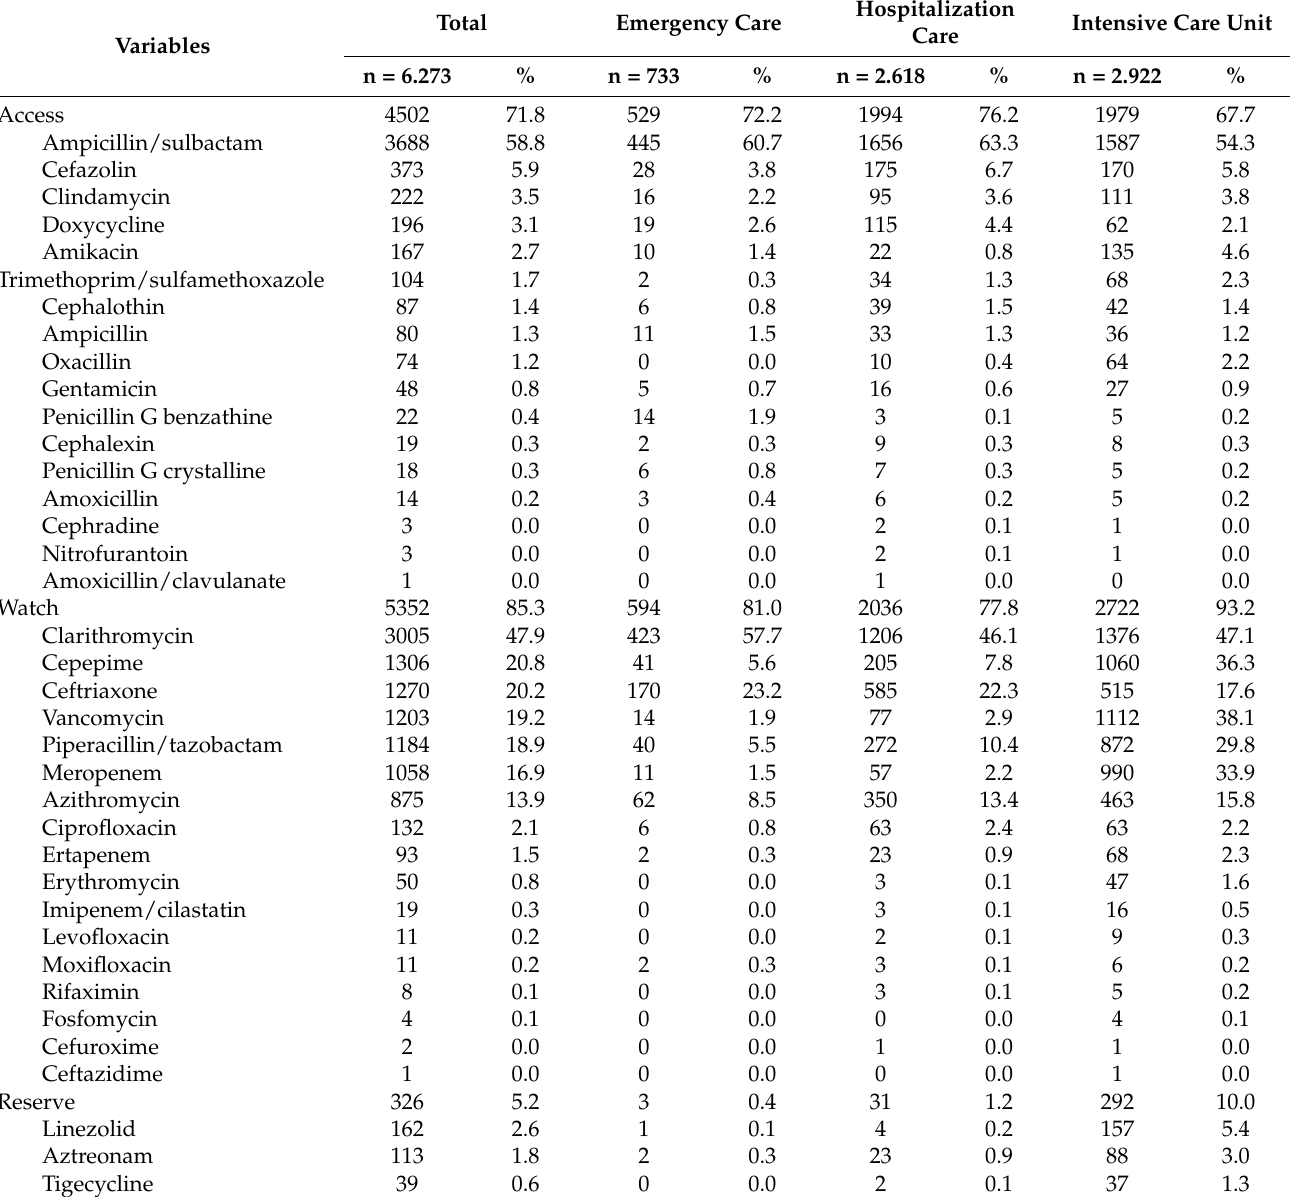
Table 2. AwaRe (Access, Watch, and Reserve) classification of 6273 patients diagnosed with COVID-19 who received systemic antibiotics by the care service in eight highly complex clinics in